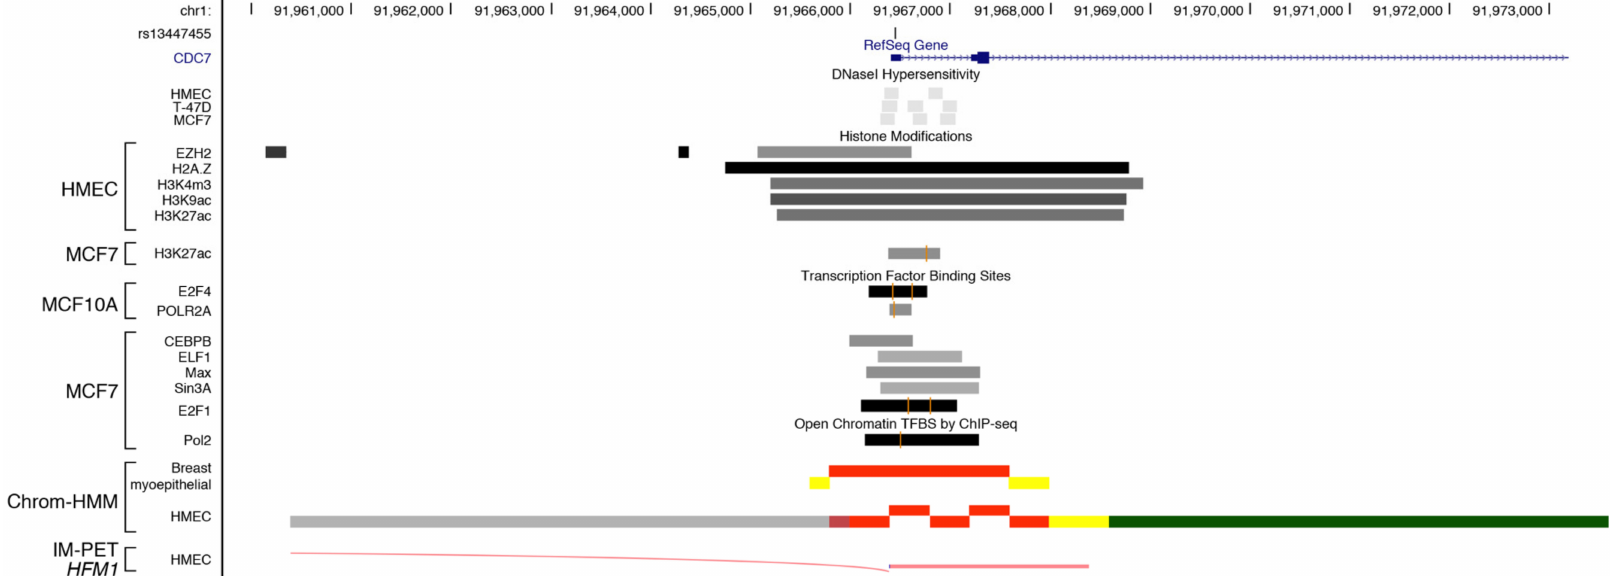
Figure 5. Functional annotation of SNP rs13447455. Functional annotation was performed using data from the Encyclopedia of DNA Elements (ENCODE) and NIH Roadmap Epigenomics projects. From top to bottom, epigenetic signals overlapping rs13447455 included DNase clusters in HMEC, T47D and MCF7 cells; histone modifications in HMEC, MCF10A and MCF7 cell lines; overlap between rs13447455 and transcription factor binding sites in MCF10A and MCF7 cells; chromatin state segmentation by Hidden Markov Model (ChromHMM) in breast myoepithelial and HMEC cells, where red represents an active promoter region, yellow a poised enhancer and green a transcribed region respectively (the detailed color scheme of chromatin states is described in the UCSC browser). Predicted enhancer-promoter determined interactions in HMEC cells, as defined by the integrated method for predicting enhancer targets (IM-PET) are